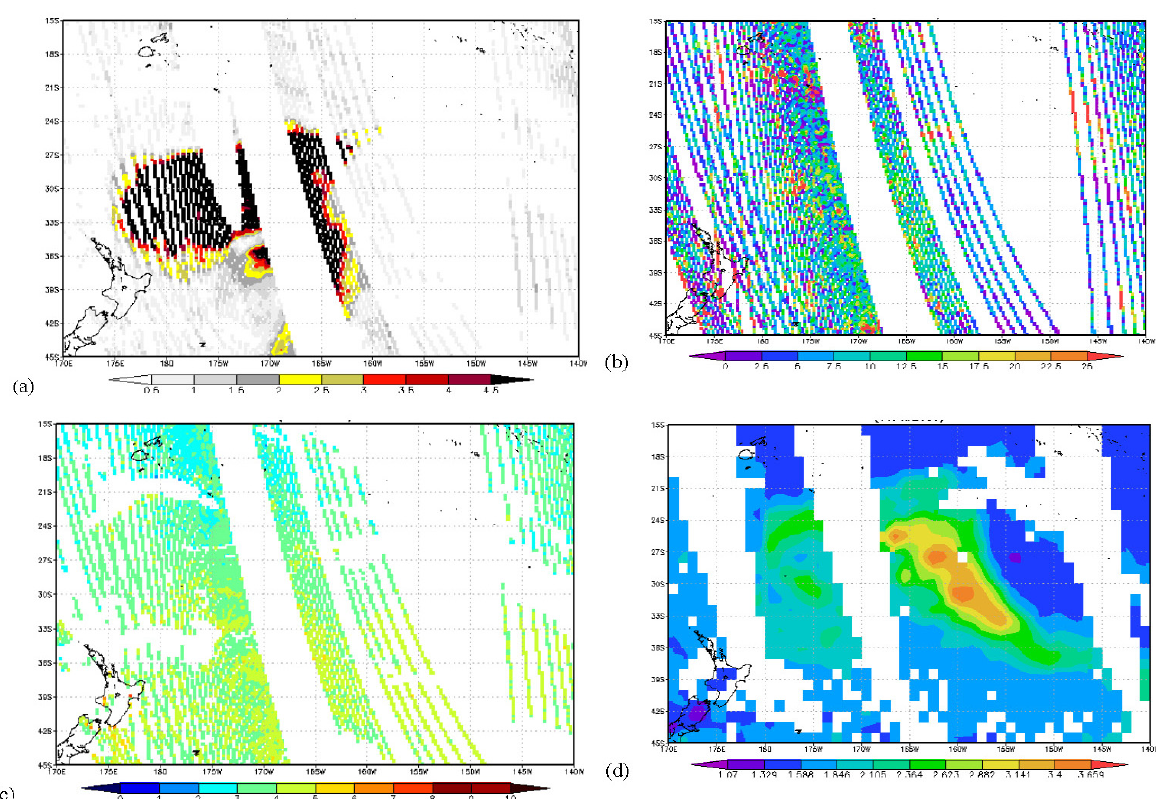
CO total 2 total column amount 2